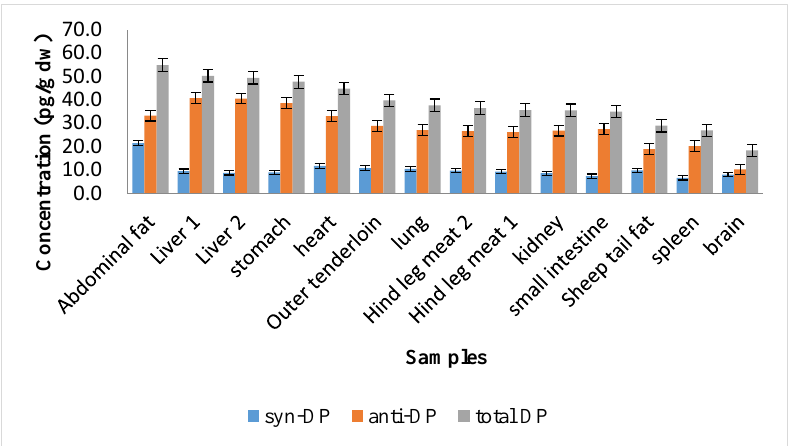
Figure 1. Concentrations of syn-Dechlorane plus (DP), anti-DP, and total DP in various sheep tissues.